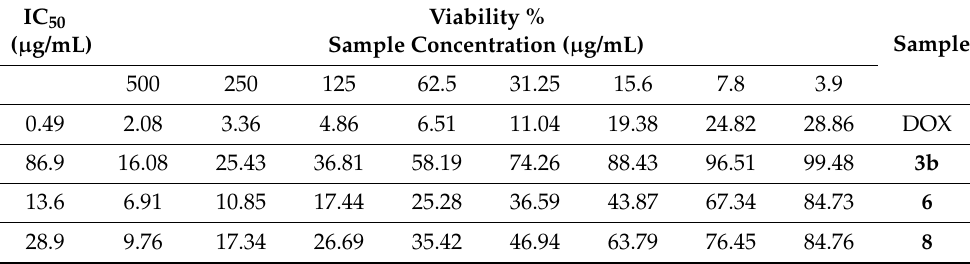
Table 3. Viability values and IC 50 of evaluated compounds against colon carcinoma cell line